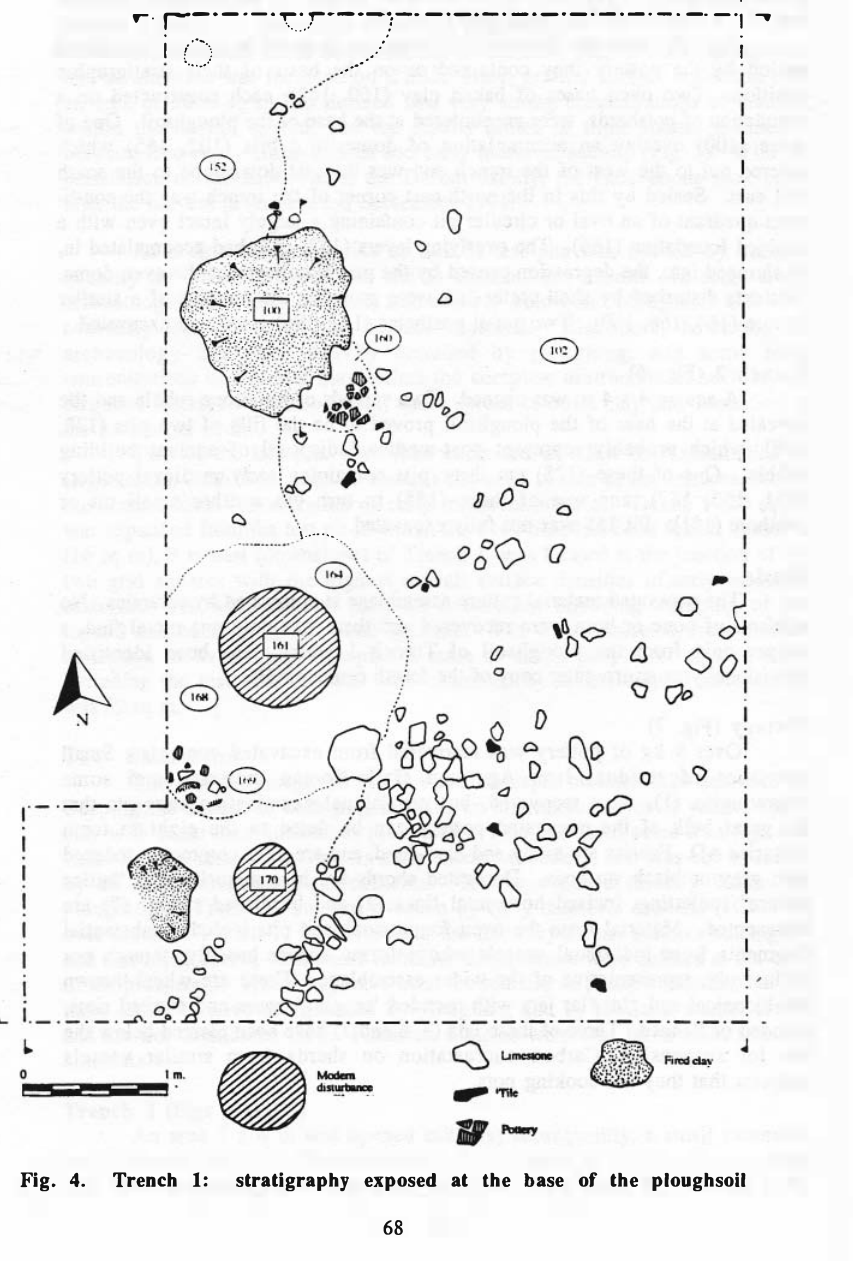
Fig. 4_ Trench 1: stratigraphy exposed at the base of the